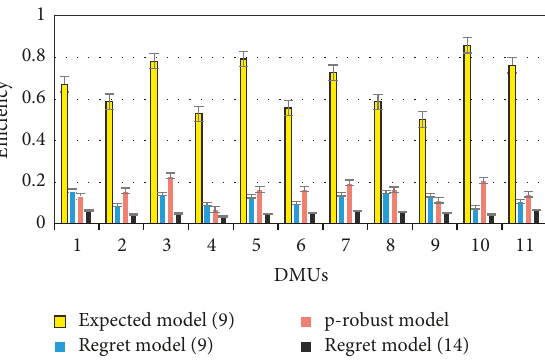
Figure 4: Comparison of regret and expected efficiency of models (9) and (14). Table 12: The gap values of model (9).